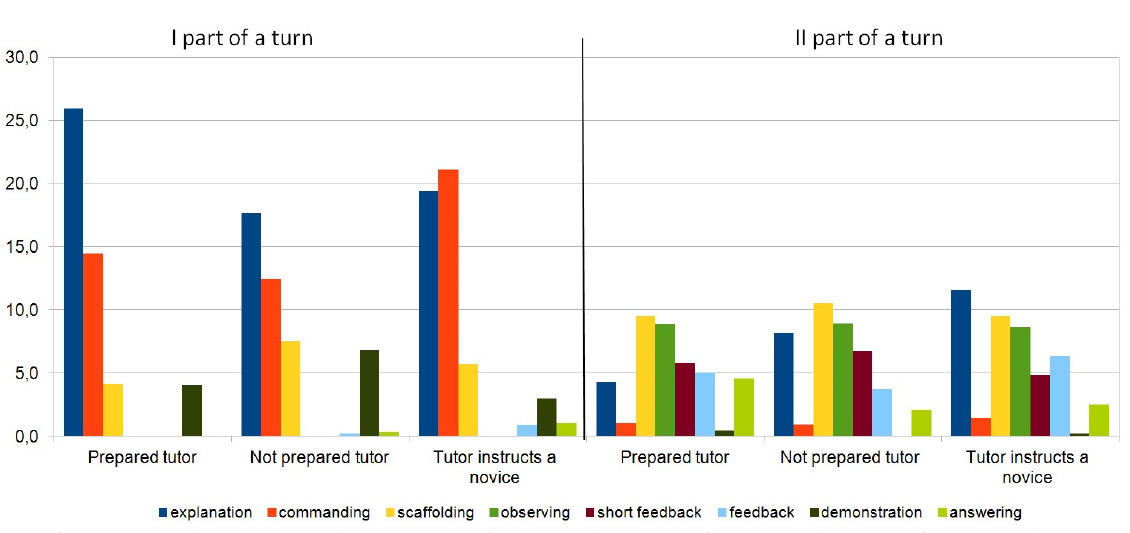
Figure 2. Most frequently used techniques in case of tutors with different level of preparation (proportion of all the